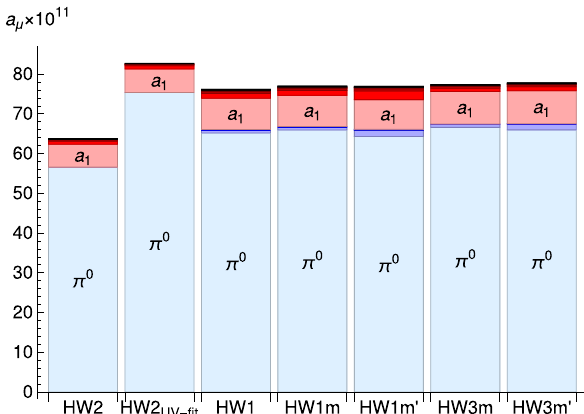
Fig. 11 Barchartoftheindividualcontributionsto a π ∪ a 1 μ inthevarious HW models, with excited modes given by increasingly darker colors, blue for the π 0 ’s, red for the a 1